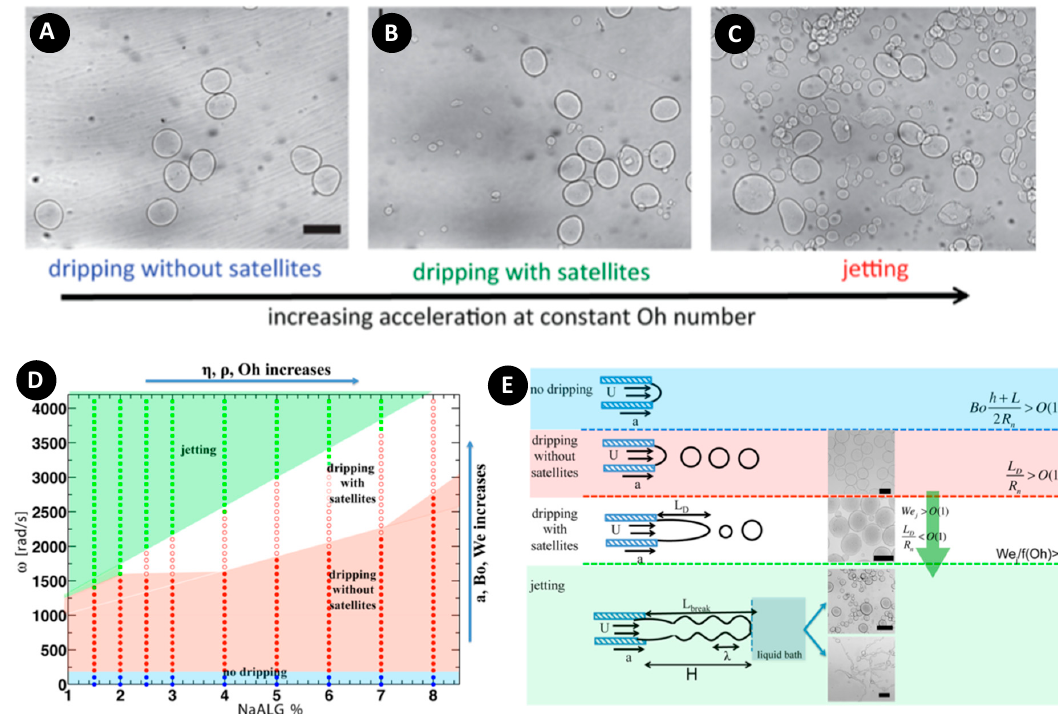
Figure 11. ( A – C ) Microscope images of produced particles at different acceleration corresponding to different regimes. (A) Dripping without satellites; (B) Dripping with satellites; and (C) Jetting; ( D ) Experimental phase diagram showing different break-offs of droplets as a function of rotational speed and Na-alginate concentration; ( E ) Illustration of different pinch-off regimes. Microscope images of particles at different accelerations. Reprinted with permission from [69].